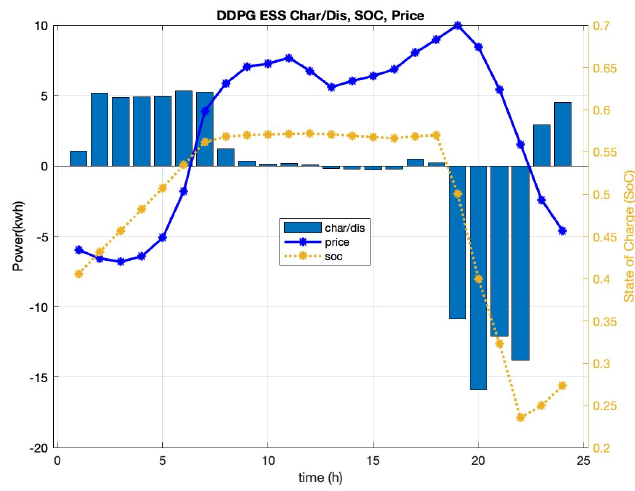
Figure 7. BESS power, SOC, and price profile .